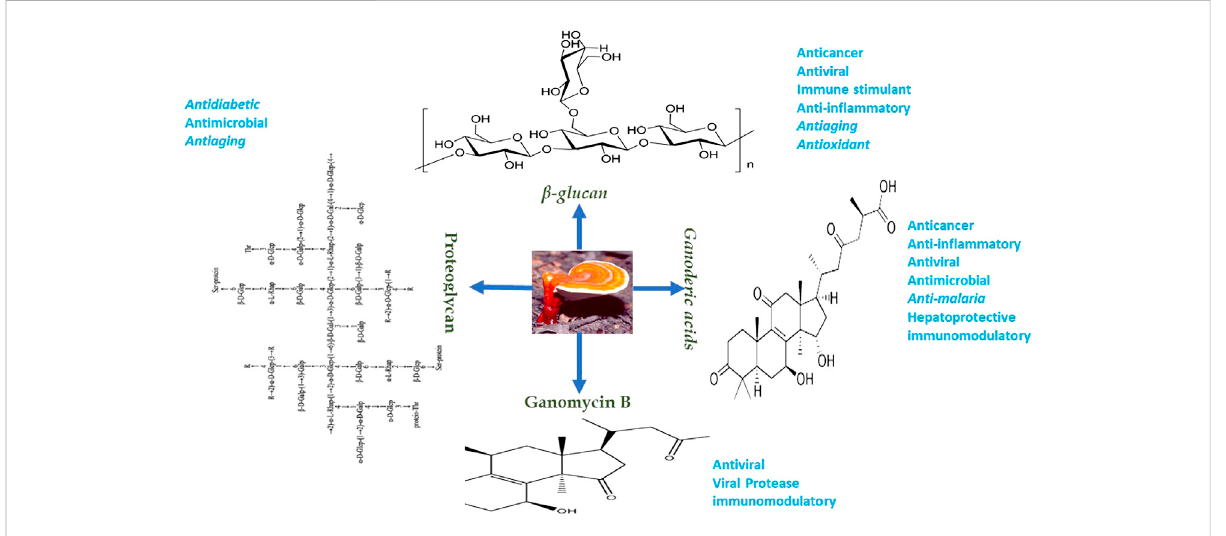
FIGURE 3 Therapeutic importance of G. lucidum bioactive